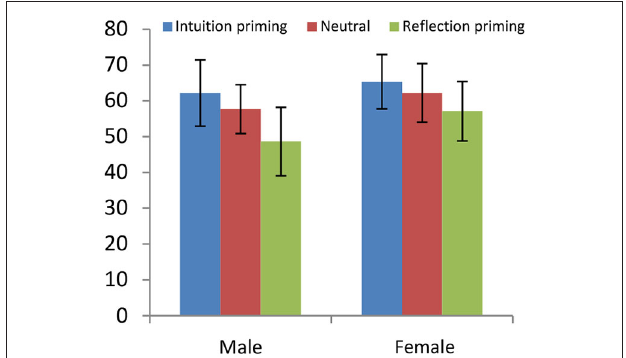
FIGURE 8 | Average percentage contribution in the PGG under three differing conditions: Intuition Priming , neither intuition nor reflection are enhanced ( Benchmark ), and Reflection Priming (Rand et al., 2010). No gender is affected by Priming Intuition ; only men react to Reflection Priming significantly decreasing their